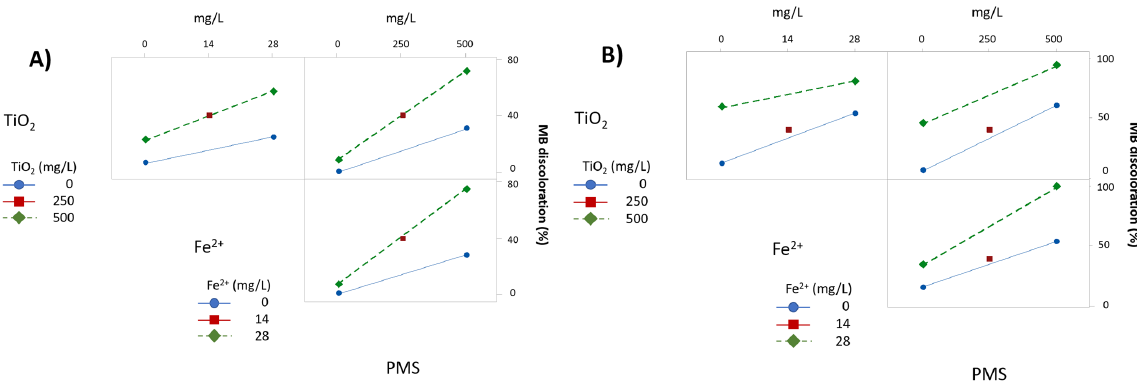
Figure 7. Interaction of variables plot under ( A ) UV-A radiation; ( B ) UV-C radiation, at 5 min of treatment.